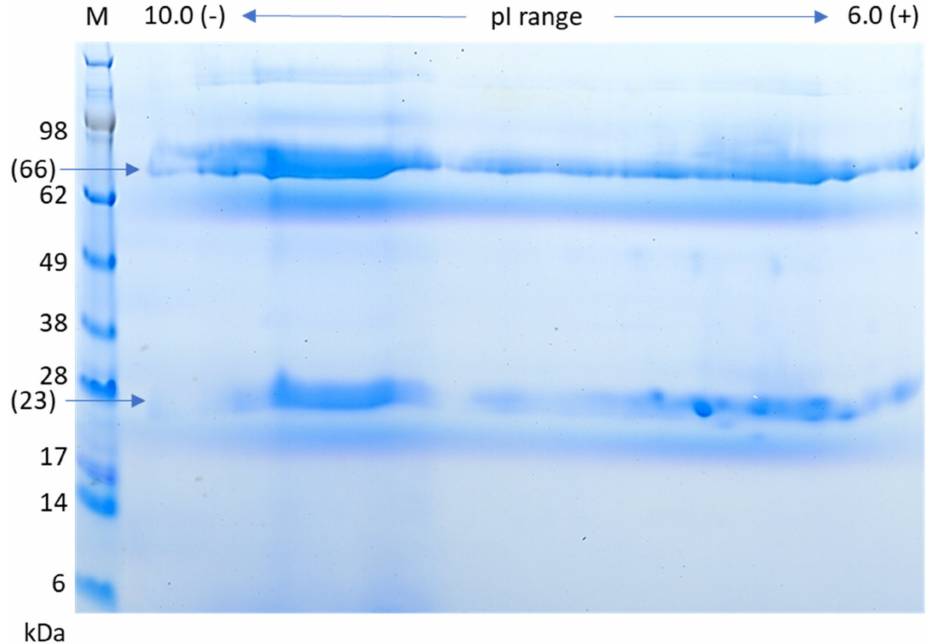
Figure 4. Two-dimensional gel electrophoresis of partially purified IgM protein of channel catfish immunized with virulent Aeromonas hydrophila ECP antigens. Positions of IgM heavy chain (approxi- mately 66 kDa) and light chain (approximately 23 kDa) were indicated by arrows. M: SeeBlue plus2 pre-stained standards